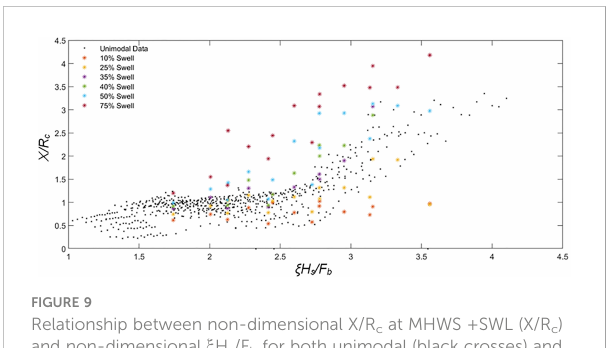
FIGURE 9 Relationship between non-dimensional X/R c at MHWS +SWL (X/R c ) and non-dimensional x H s /F b for both unimodal (black crosses) and bimodal (coloured symbols) storm